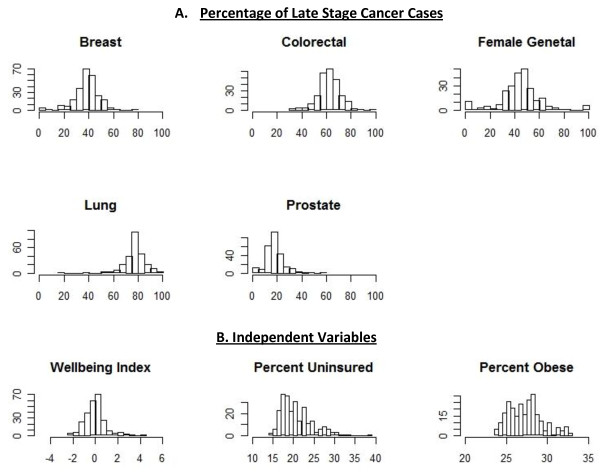
Empirical Histograms of Relevant Variables, by Texas Counties.A. X axis is the percentage of late stage cases for each cancer; Y axis is frequency (number of counties). B. X axis is the independent variable; Y axis is frequency.